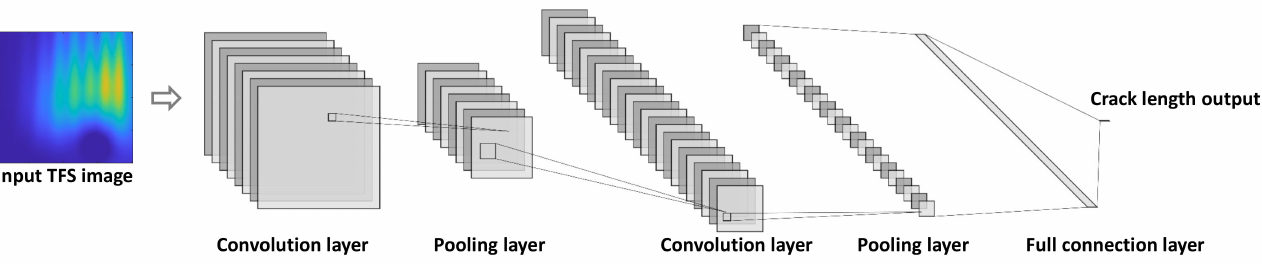
Figure 2. Architecture of a typical